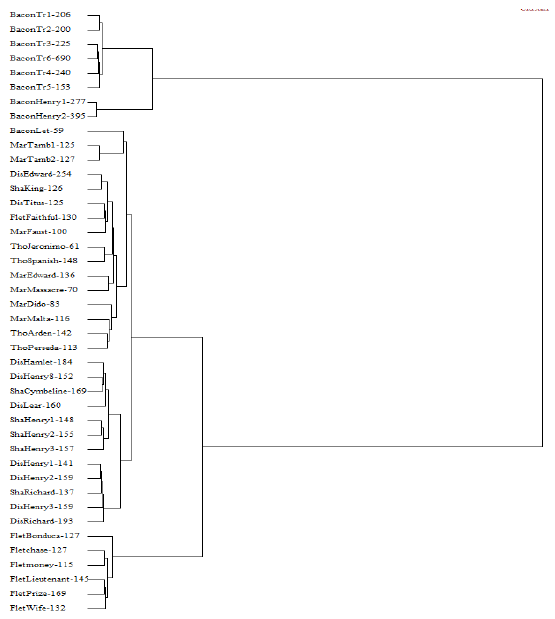
Figure 3. A linear hierarchical cluster analysis of a 42 × 60 dimensionality-reduced and length-normalized D FW using Squared Euclidean distance and an increase in sum of